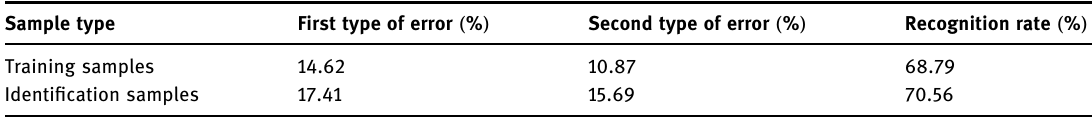
Table 2: Identi fi cation results based on k - means clustering algorithm Sample type